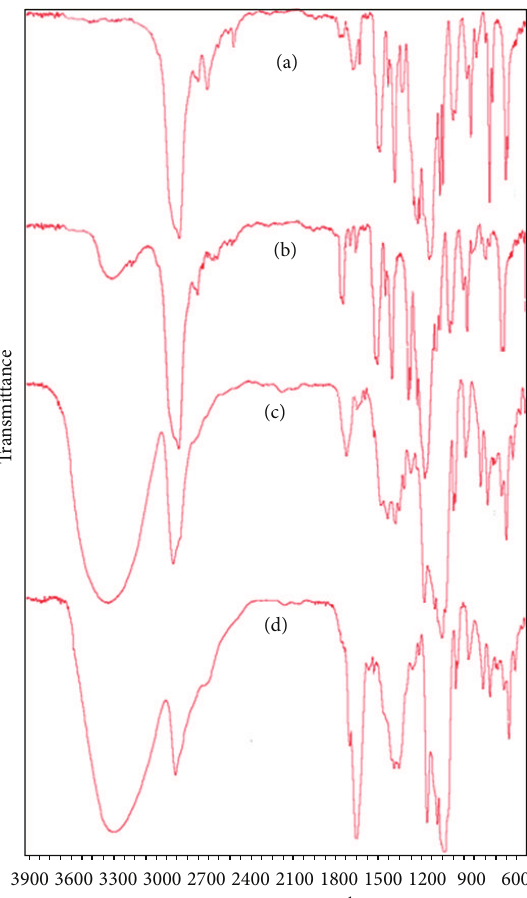
Figure 1: IR spectra of PEG-diOTs (a) in CH 2 Cl 2 , PEG-diThy (b) in CH 2 Cl 2 ,Ps-PR(c)usingKBrtablet, and PPR-Fl(d)usingKBrtablet.